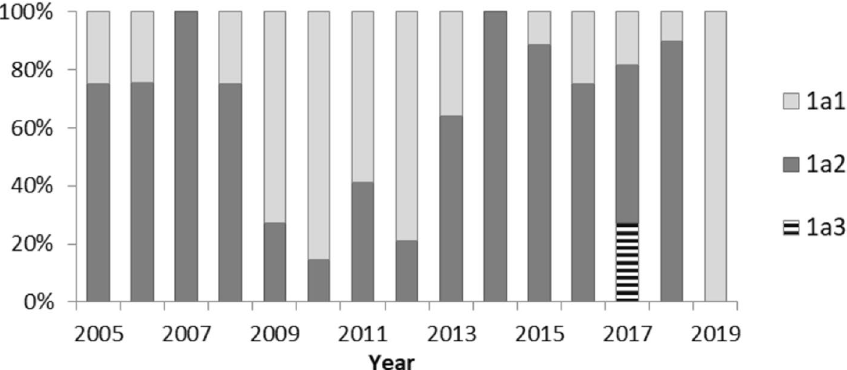
Figure 6. Prevalence of B19V 1a subtypes in individual years, Belarus, 2005–2019.